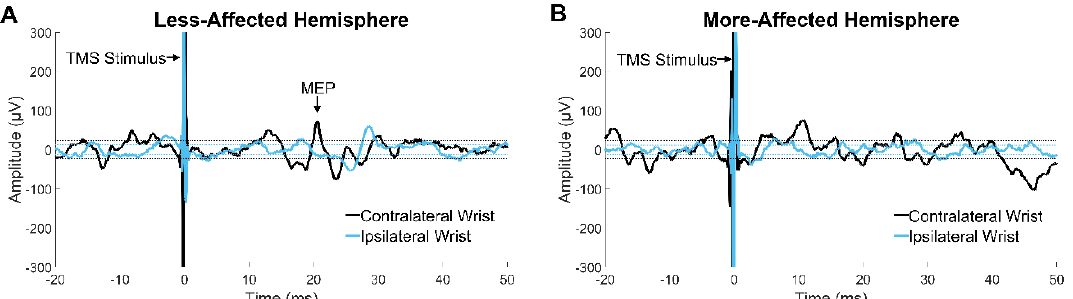
Figure 2. Surface electromyography (EMG) recording from the contralateral (black line) and ipsilateral (blue line) wrist flexors in a 12-month-old infant with unilateral perinatal stroke. ( A ) Motor evoked potential (MEP) in the contralateral wrist flexor elicited by transcranial magnetic stimulation (TMS) of the less-affected hemisphere. ( B ) EMG signal displaying absence of MEP in either wrist flexor after TMS of the more-affected hemisphere. Both traces A and B were recorded at a TMS intensity of 85% of maximum stimulator output. Table 2. Presence of MEPs from TMS of each hemisphere by corrected and gestational age groups.